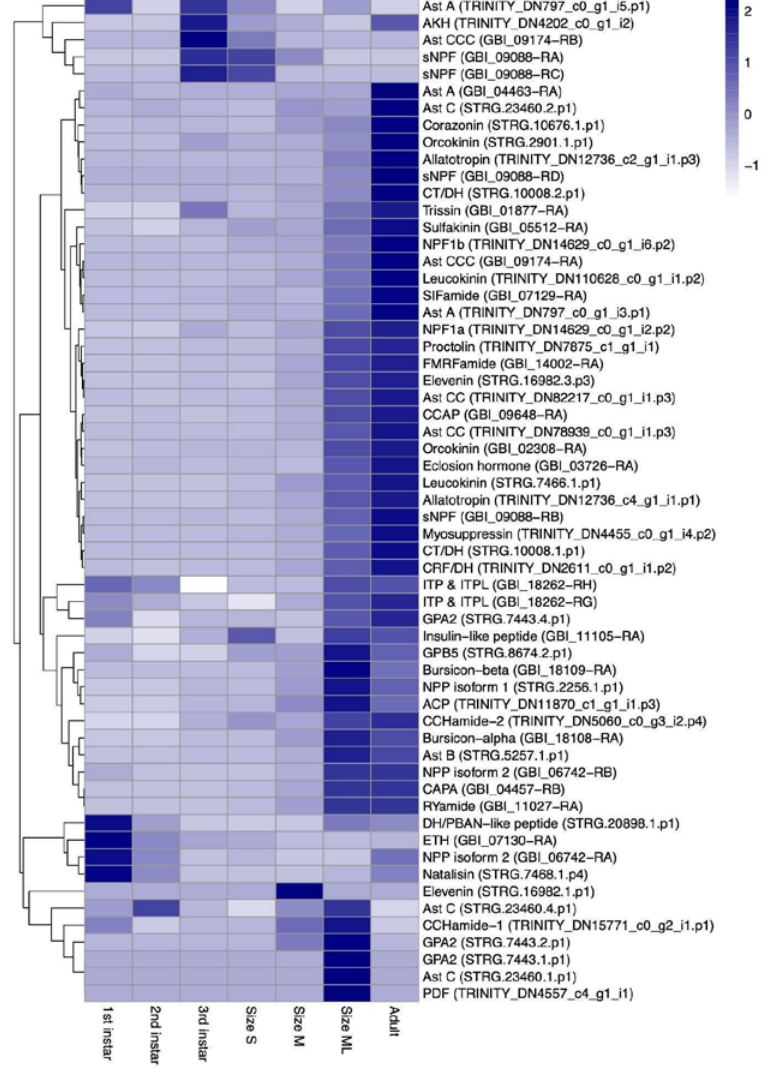
Figure 2. Heatmap of the normalized TPM value for neuropeptides. The expression analysis was performed with the public RNA-seq data for the whole body of G. bimaculatus (SRP311541) to validate the neuropeptide annotations. Trissin (GBI_01877-RB) and Elevenin (STRG.16982.2.p3) were removed from the heatmap because they had transcript per million (TPM) values of 0 in all samples. The sizes S, M, and ML indicate the size of wingless juvenile; 6–10 mm (size S), 10–15 mm (size M), and 15–20 mm (size ML).